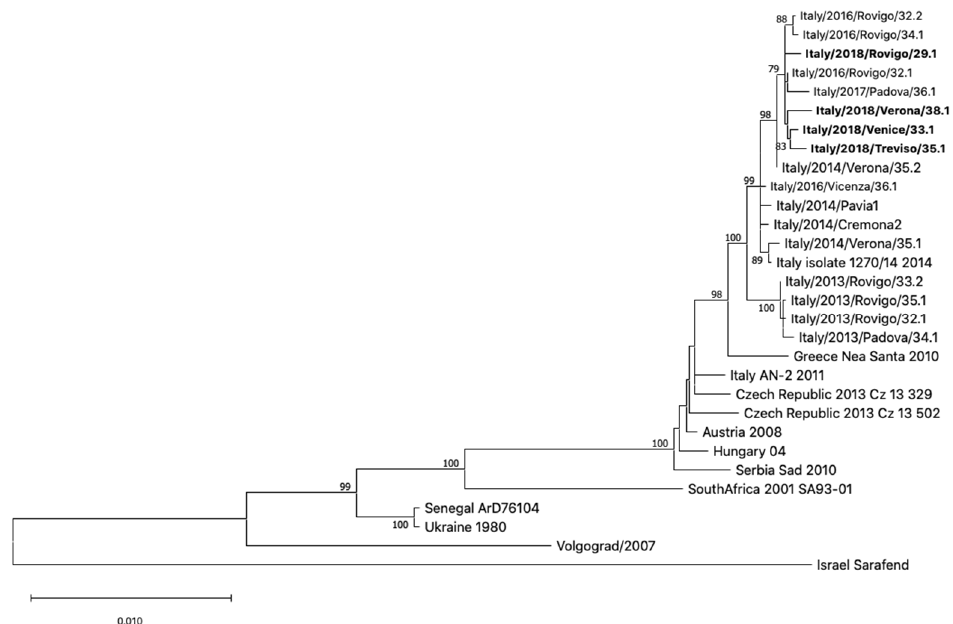
Figure 8. Phylogenetic tree of WNV full-genome sequences. The complete WNV genome sequences obtained in this study are highlighted in bold. The evolutionary history was inferred by using the maximum likelihood method and general time reversible model. The percentage of trees in which the associated taxa clustered together is shown next to the branches. The tree is drawn to scale, with branch lengths measured in the number of substitutions per site. This analysis involved 30 nucleotide sequences. All positions containing gaps and missing data were eliminated. There were a total of 7271 positions in the final dataset. Evolutionary analyses were conducted in MEGA X.